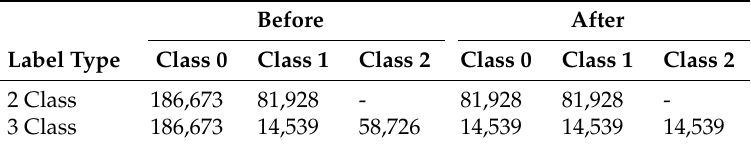
Table 5. Effects of under-sampling the majority demonstrating the differences between the full dataset and balanced